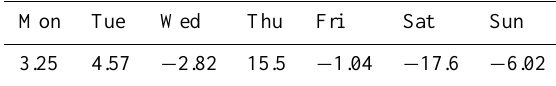
Table 1. AOD Percentage Departure from Weekly Average at 440nm at Shanghai Pudong Site (%), the italic numbers indicates that the values are different from the weekly average above 90% confidence.